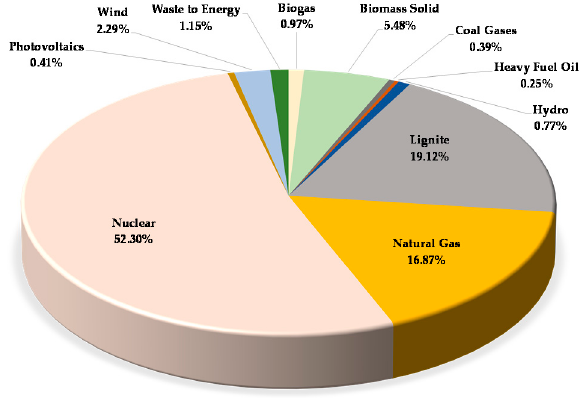
Figure 2. Hungarian electricity mix.